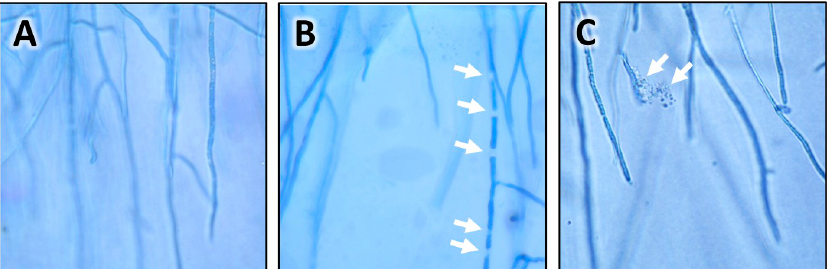
Fig 7. Bacterial metabolite-mediated cytopathic effects on hyphae of the chalkbrood fungus. Light microscopy images of chalkbrood mycelia that were grown on thin potato dextrose agar (PDA). ( A ) Mycelium of an untreated control; ( B , C ) mycelia that were treated with a semi-purified crude extract of Pseudomonas strain AN5. In panel B, the arrows indicate fragmentation due to a breakdown of septae; in panel C, the arrows indicate hyphal lysis and cytoplasmic leakage. Magnification, 1,000 ×